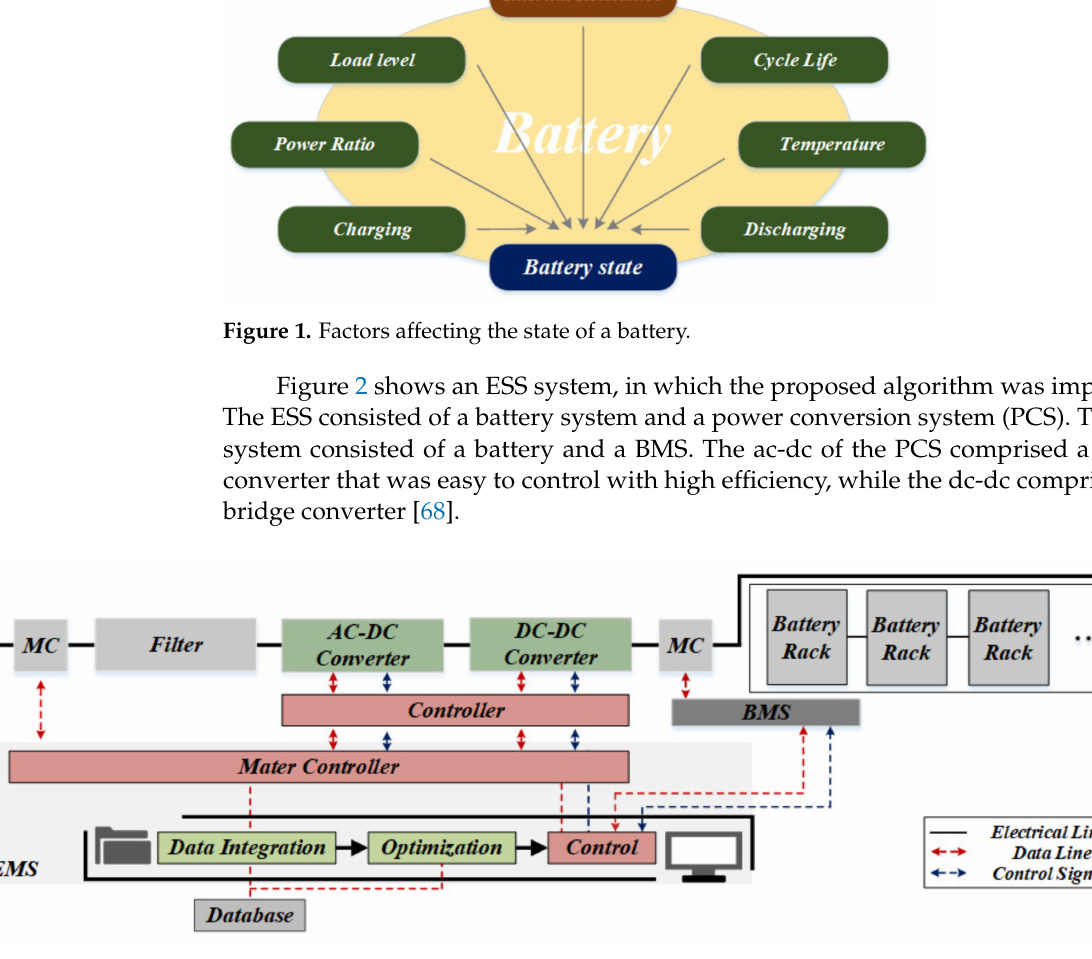
Figure 2. Proposed ESS configuration